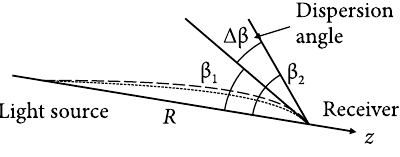
Fig. 5. Configuration of the dispersometer set-up